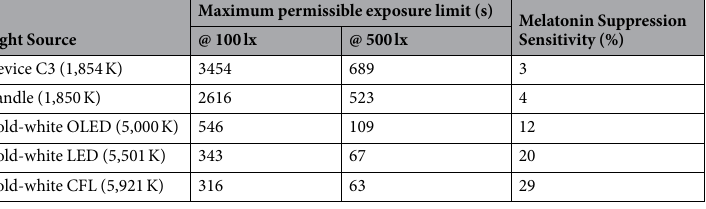
Table 1. Comparison of a fabricated OLED (1,854 K) with existing lighting measures in terms of retina maximum permissible exposure limit “t” (sec) and melatonin suppression sensitivity (%).